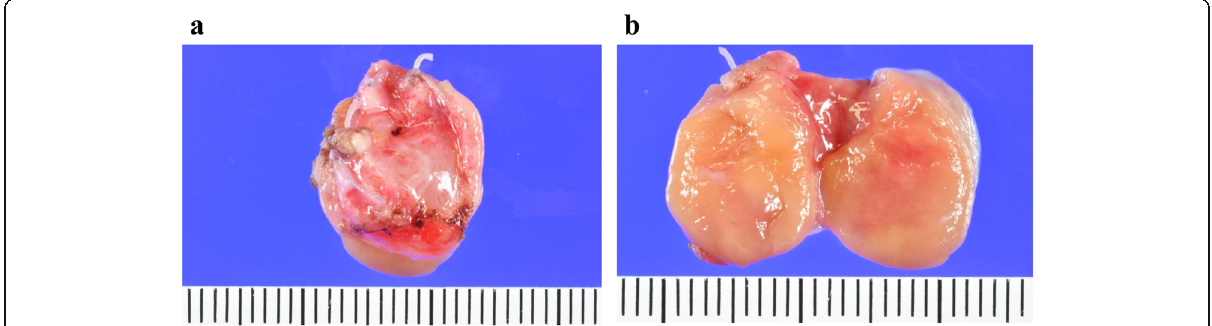
Fig 3 Photos of the resected specimen. a The oval, soft tumor, 15 × 12 × 9 mm in size. b The split face of the